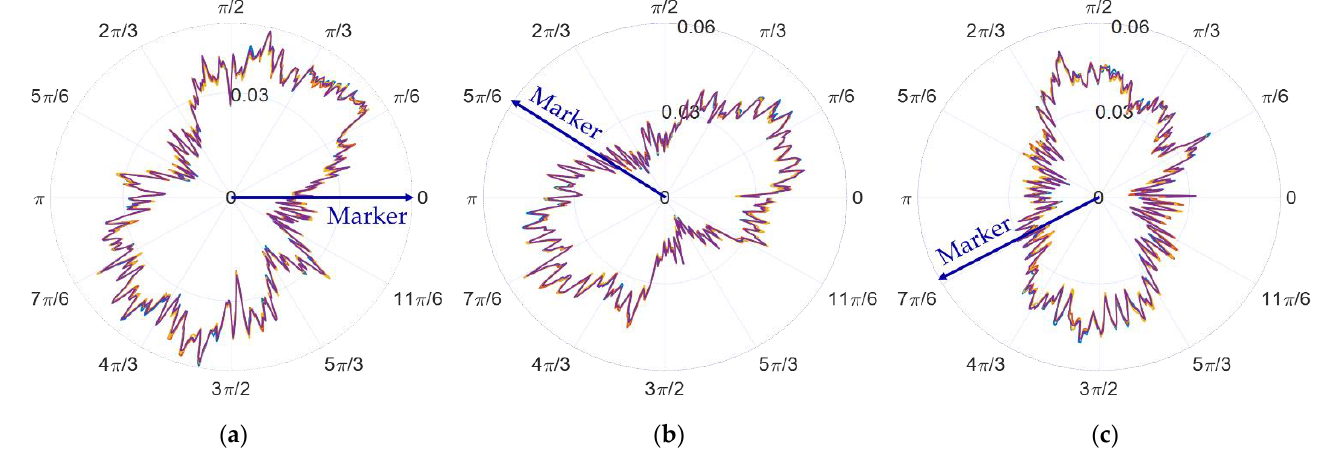
Figure 12. Amplitude phase diagrams of the multi-turn sampling data of the three sensors with the eccentricity and synchronization error removed in the polar coordinate system: ( a ) data from sensor A, ( b ) data from sensor B, and ( c ) data from sensor C.